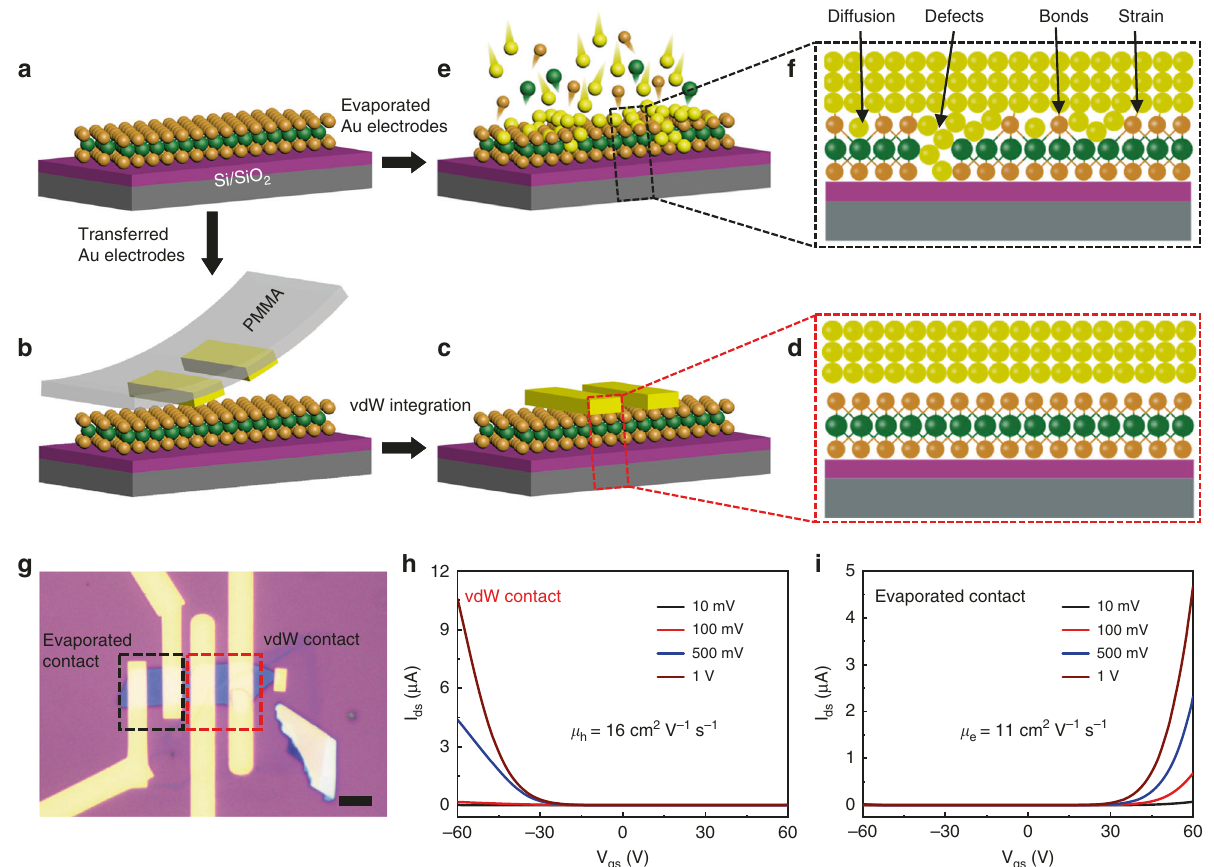
Fig. 1 Schematical illustration of device structure and electrical measurement. a – c Fabrication processes of WSe 2 transistors using vdW integration processes: WSe 2 fl ake exfoliated onto Si/SiO 2 substrate ( a ); pre-fabricated Au electrodes physically laminated on WSe 2 surface with weak vdW interaction ( b , c ). d The cross-sectional schematic of vdW contact with WSe 2 , demonstrating clean and sharp interfaces. e Au electrode evaporated on WSe 2 using conventional thermal evaporation. f The cross-sectional schematics of evaporated contact with WSe 2 , demonstrating a highly disordered interface. g Optical image of a typical fabricated device with both evaporated (left pair, highlighted by a black box) and vdW-integrated (right pair, highlighted by a red box) electrodes on the same WSe 2 fl ake (~7-nm thick). The scale bar is 5 μ m. h , i The I ds − V gs transfer characteristics of the WSe 2 transistor (shown in g ) using both vdW-integrated ( h ) and conventional evaporated electrodes ( i ). By controlling the metal integration approaches, the device polarity can be switched between p- and n-type, with a carrier mobility of 16 and 11 cm 2 V − 1 s − 1 (at a bias of 1 V),